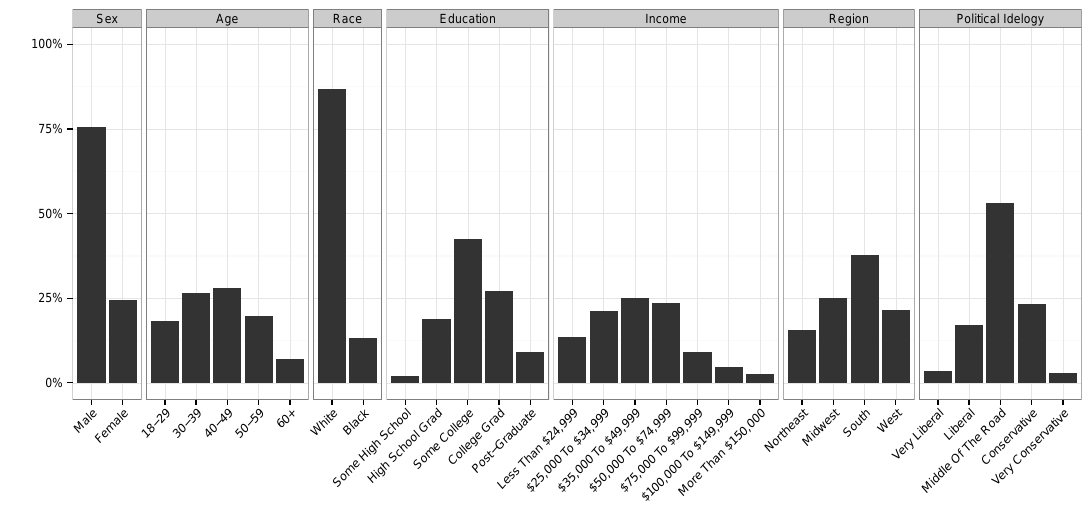
Figure 1: Demographic composition of individuals in study